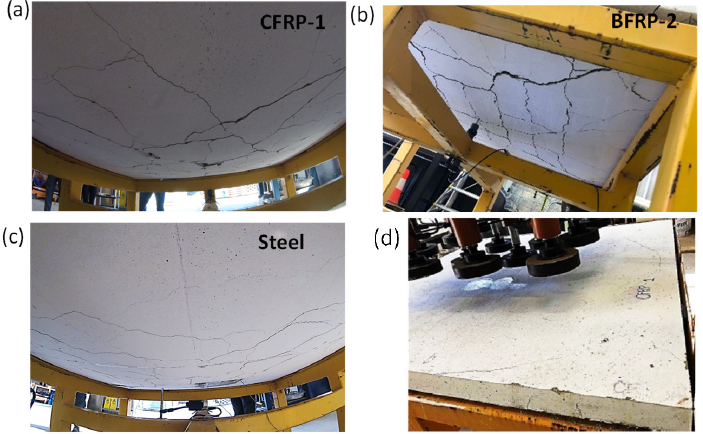
Figure 5. Failures of concrete slabs reinforced with ( a ) CFRP, ( b ) BFRP, ( c ) steel rebars, and ( d ) punching shear failure.